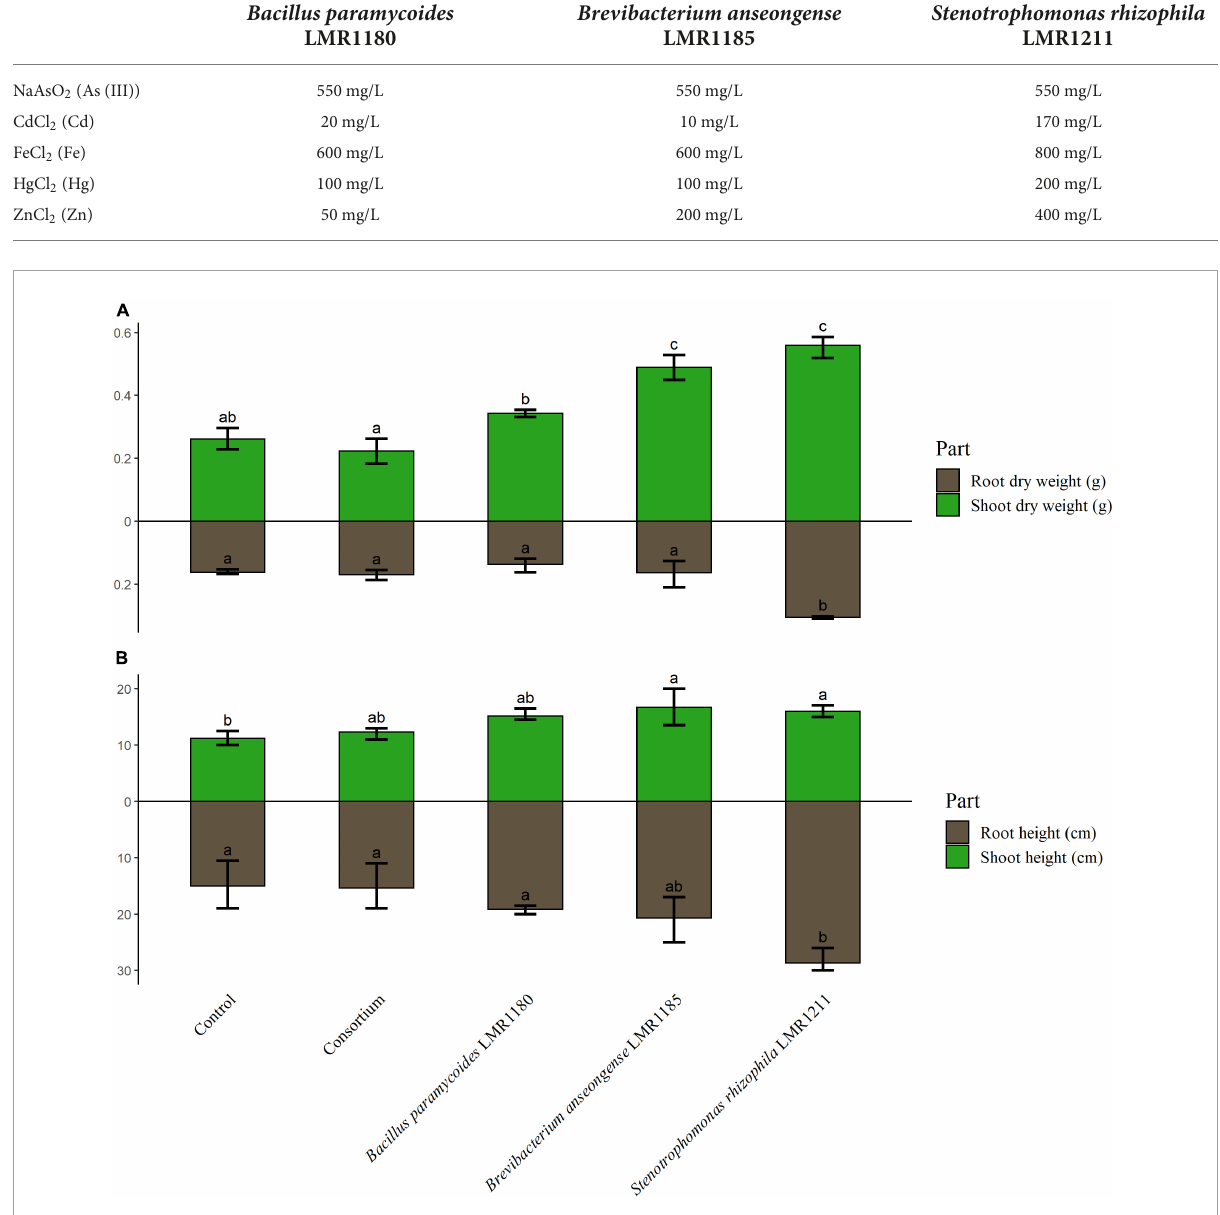
TABLE 2 Table representing the highest concentrations of toxic metals tolerated by the three selected strains ( Bacillus paramycoides LMR1180, Brevibacterium anseongense LMR1185, and Stenotrophomonas rhizophila LMR1211).